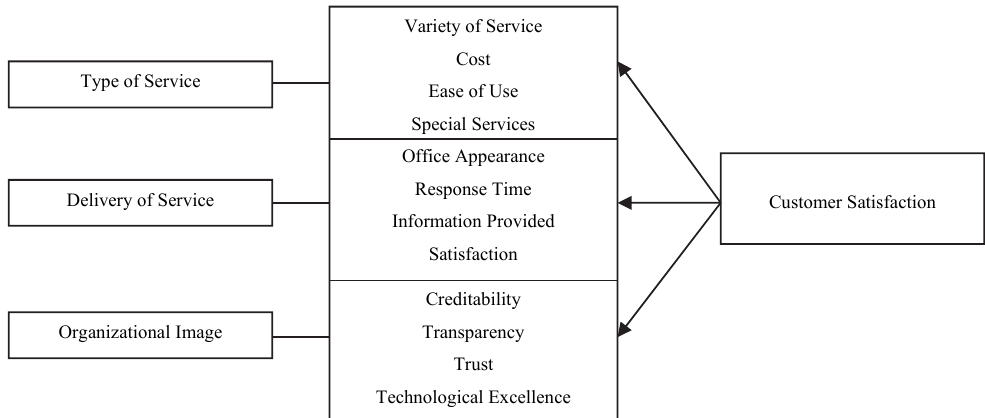
Fig. 1. Elements of customer